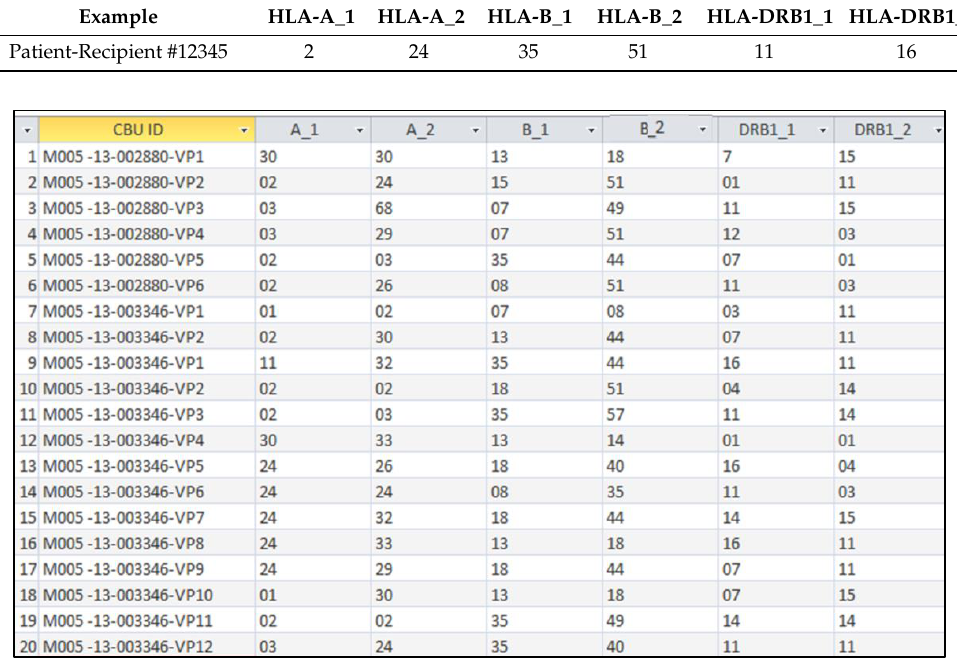
Figure 2. A representative screenshot of the “VP database” worksheet.